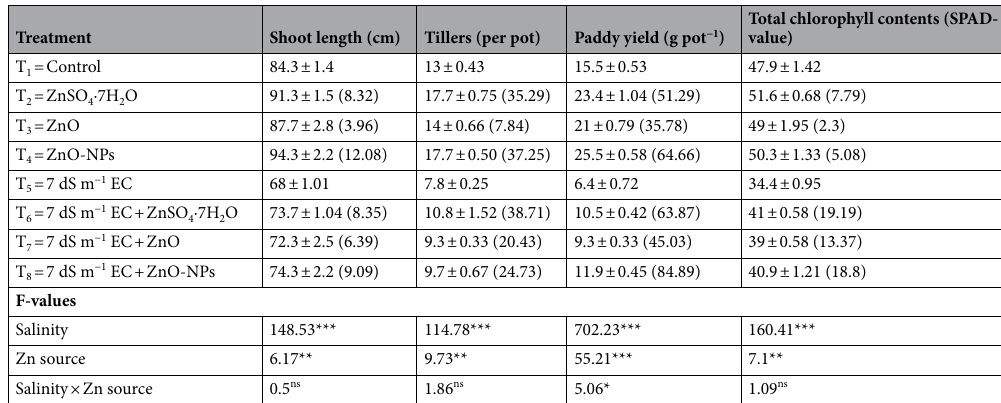
Table 5. Comparative effect of ZnO-NPs to other bulk Zn sources on growth attributes of rice. Values represent mean ± SE (n = 3). Values in parenthesis show percent increase or decrease from respective control. According to LSD test with multiple comparisons, F-values of the Two-way ANOVA are indicated as: ns not significant. *Significant at p ≤ 0.05. **Significant at p ≤ 0.01. ***Significant at p ≤ 0.001.